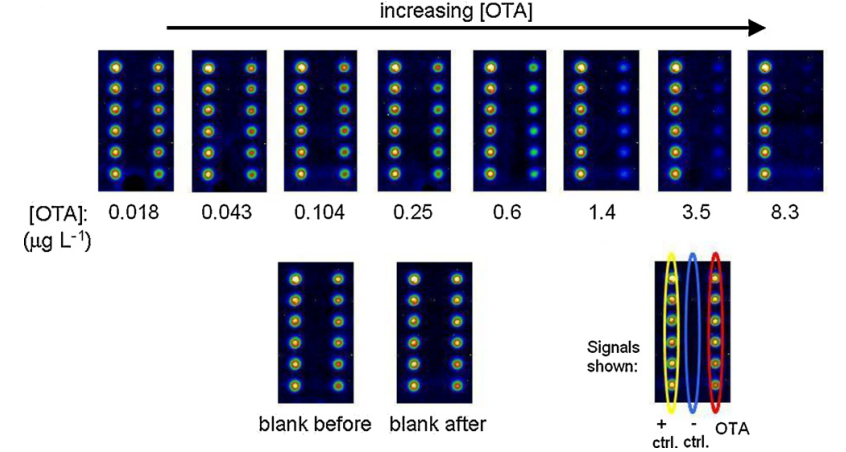
Figure 1. Images of the biochip in sequential experiments with increasing OTA concentration including blanks measured before and after calibration. (Reprinted from [40] © 2011 Elsevier